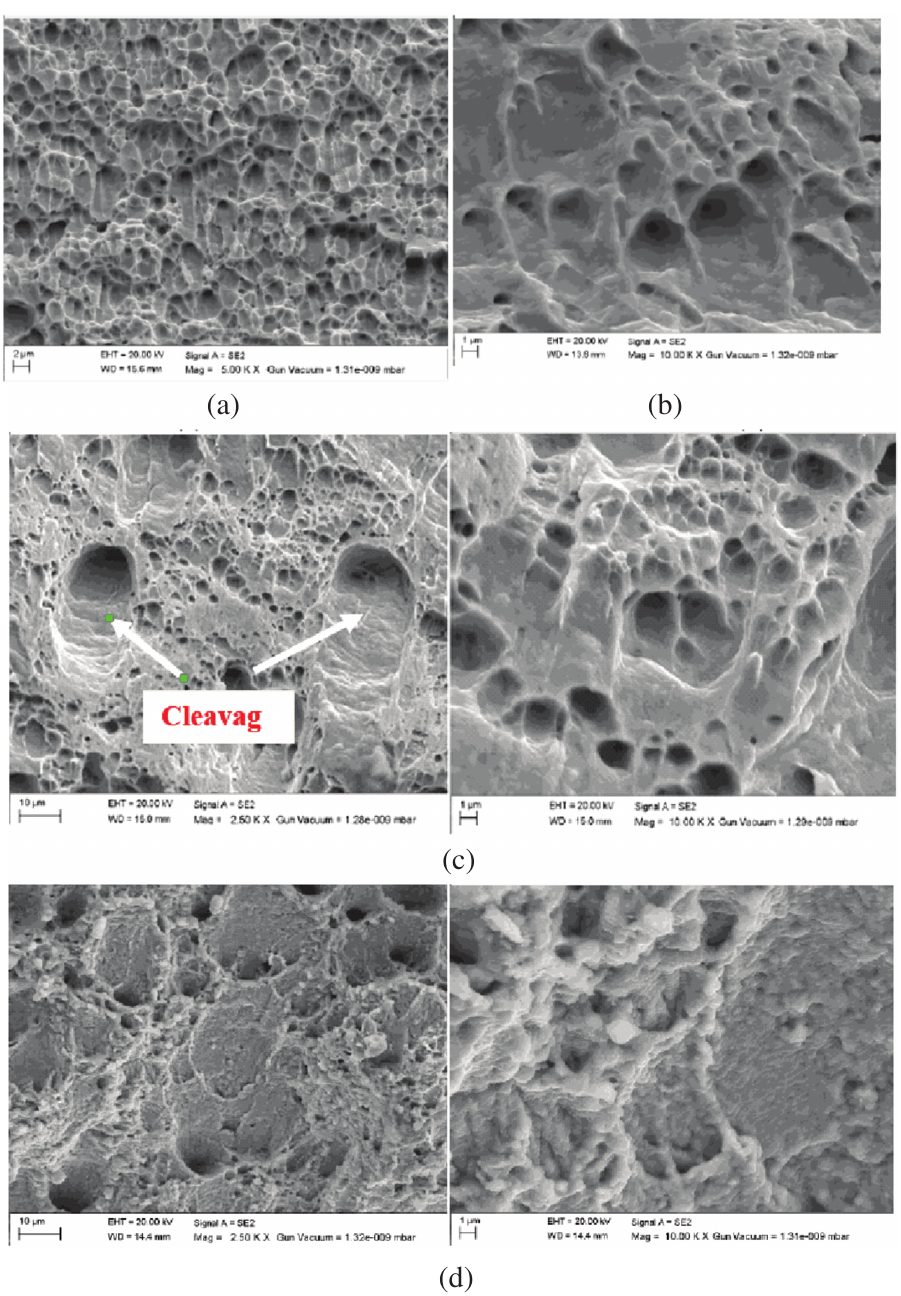
Figure 13: SEM micrographs of fractured tensile specimens for ASS 304 at various temperatures (a) 150°C (b) 300°C (C) 450°C (d)